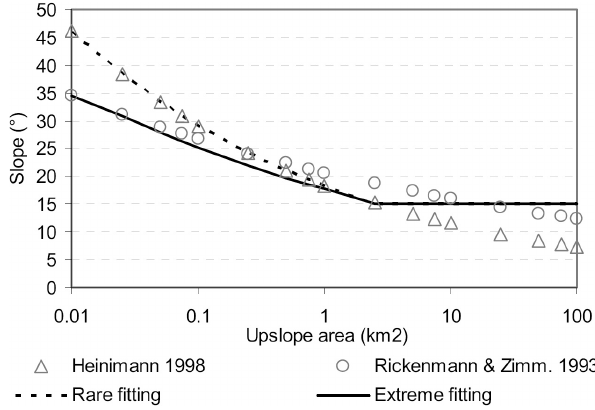
Fig. 2. Extreme and rare slope thresholds for debris-flow triggering with regard to the upslope area after Horton et al. (2008), considering Heinimann et al. (1998) and Rickenmann and Zimmermann